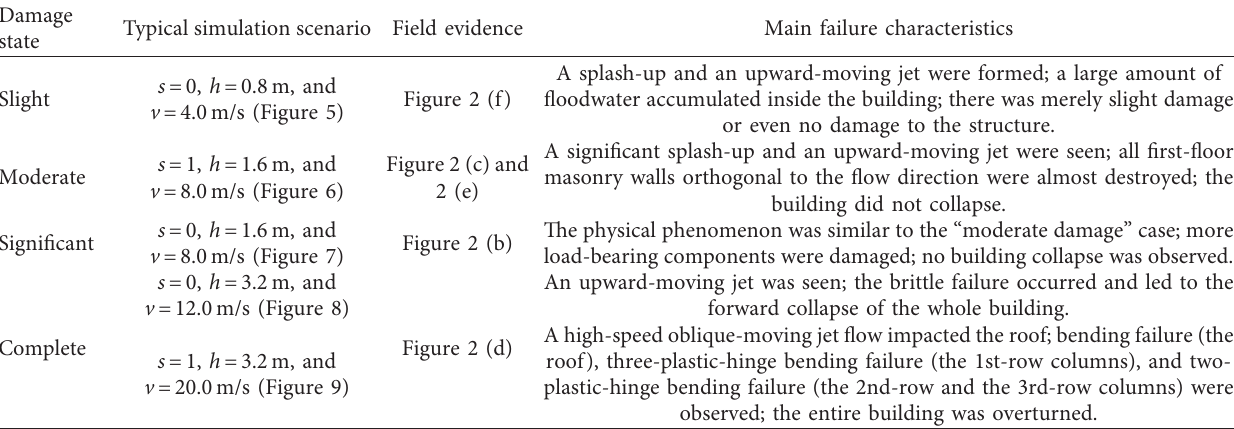
Figure 4: Time evolutions of the total impact force for tested values of contact stiffness. Table 2: Descriptions of the typical simulation scenarios.